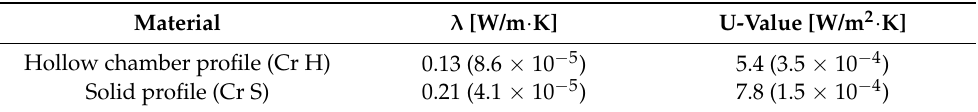
Figure 14. Weight gain of co-extruded profiles after 28 days storage in cold water. Requirements according to Table 7 were fulfilled, with the exception of the average for the solid profiles with FR CROS 490. Table 8. Thermal conductivity of co-extruded profiles with fire-retardant FR CROS 490. Values represent average of ten measurements; standard deviation in